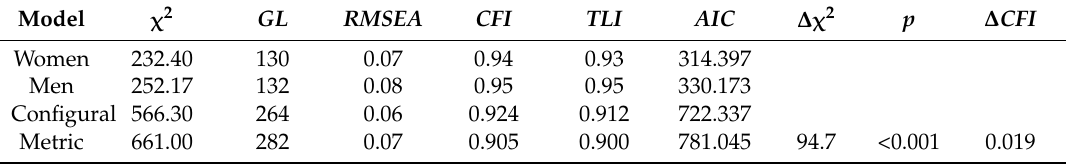
Table 7. Adjustment indexes for compared models in the factorial invariance